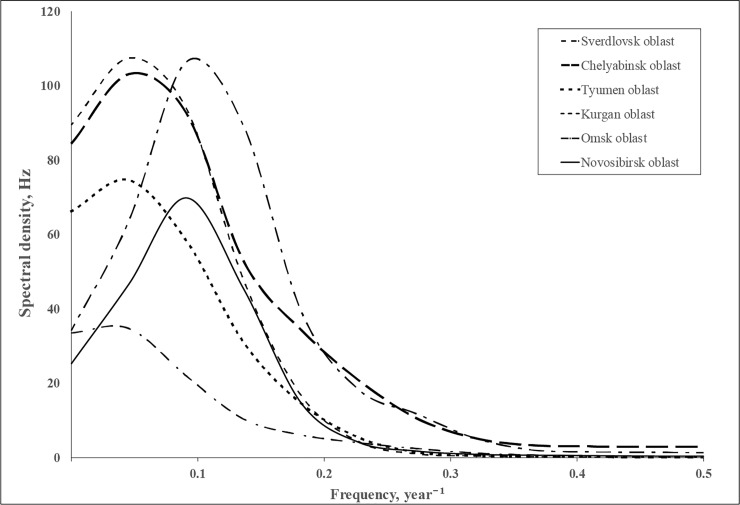
Spectral densities of log-transformed time series of squares of defoliated areas (ha).